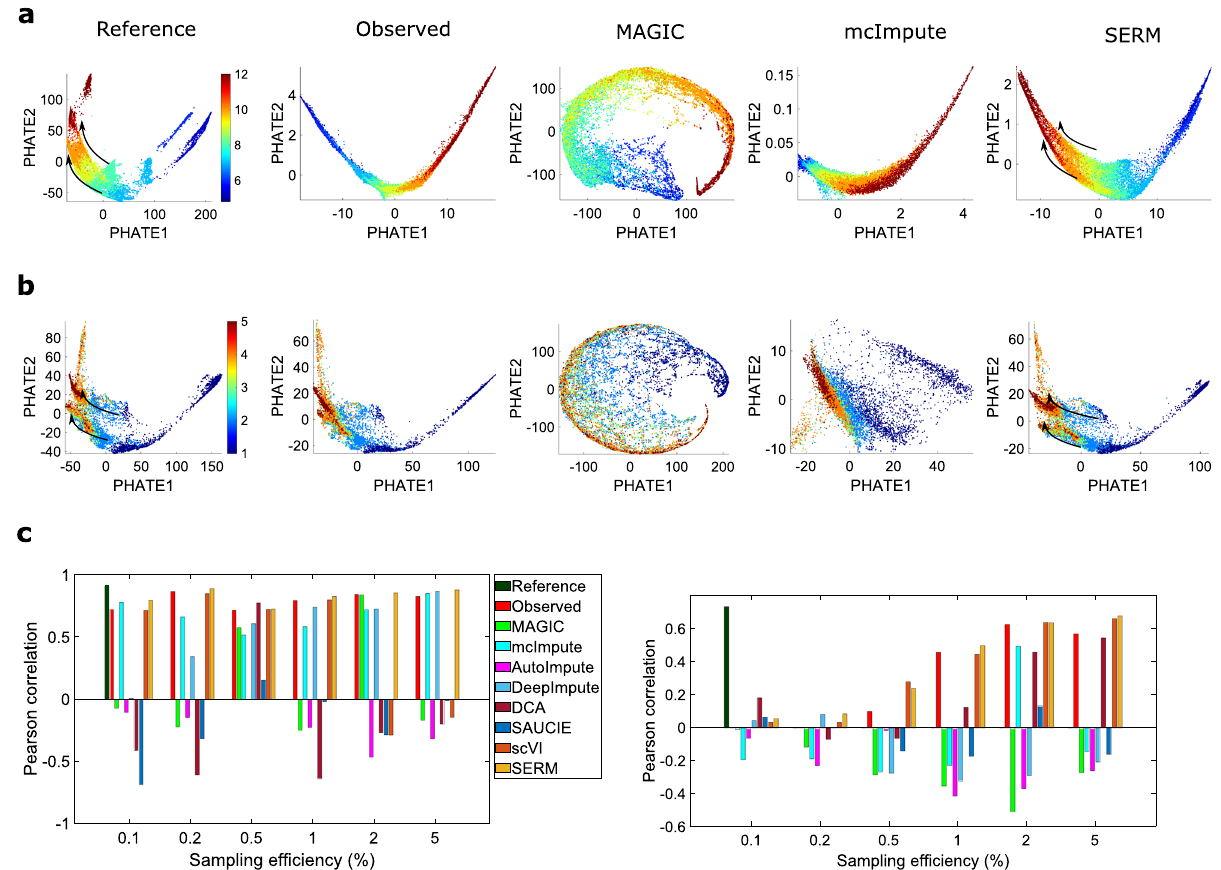
Fig. 5 | Analysis of cell trajectory in imputed data from different methods. PHATE results from the reference data ( fi rst column), observed data (second col- umn), imputed data from MAGIC, mcImpute, and SERM (columns 3 – 5) for a zebra fi sh development data and b EB differentiation data. The observed data werecreatedbysamplingthereferencedataat0.1%ef fi ciencyforbothdatasets.All the trajectories are better visualizedin SERM imputed data. MAGIC and mcImpute distort the data in both cases, whereas SERM retains the consistency of the data